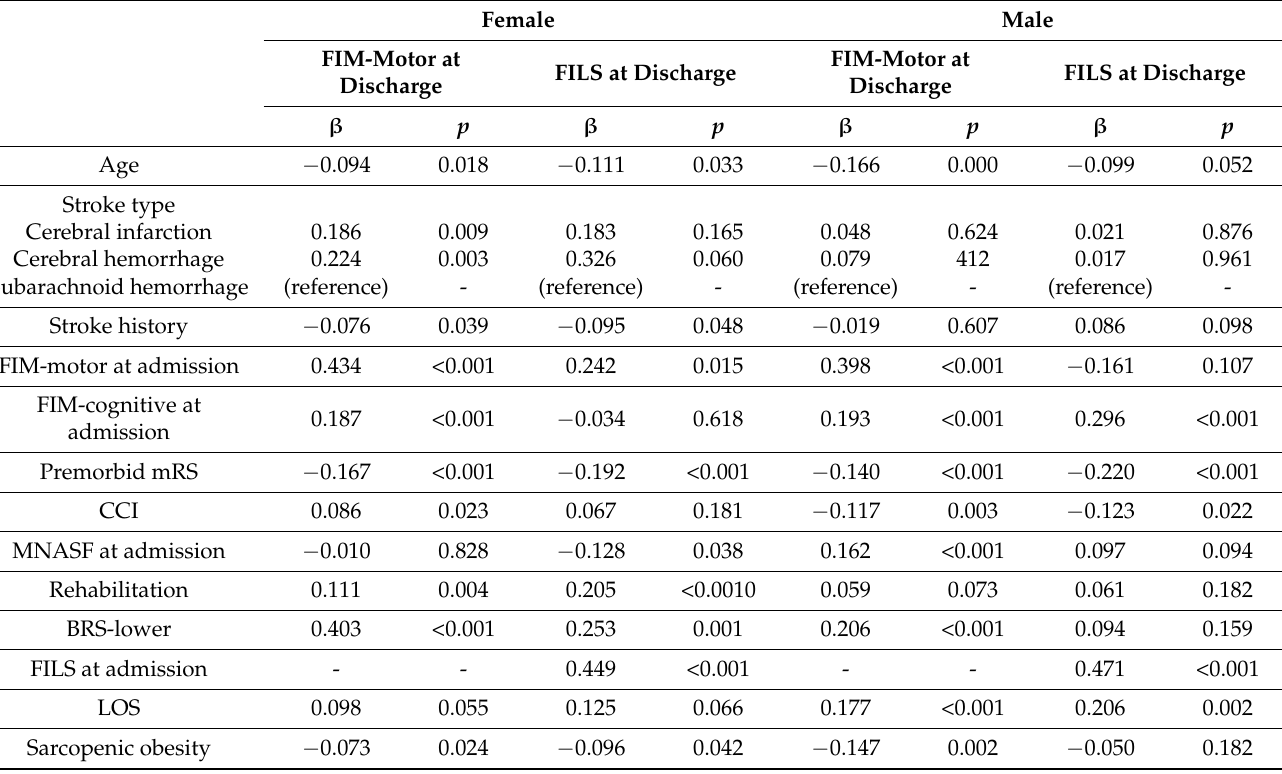
Table 5. Multivariate analyses of sarcopenic obesity defined by ESPEN and EASO criteria 2022 using BMI > 25.0 kg/m 2 as obesity screening for FIM-motor and FILS at discharge in females and